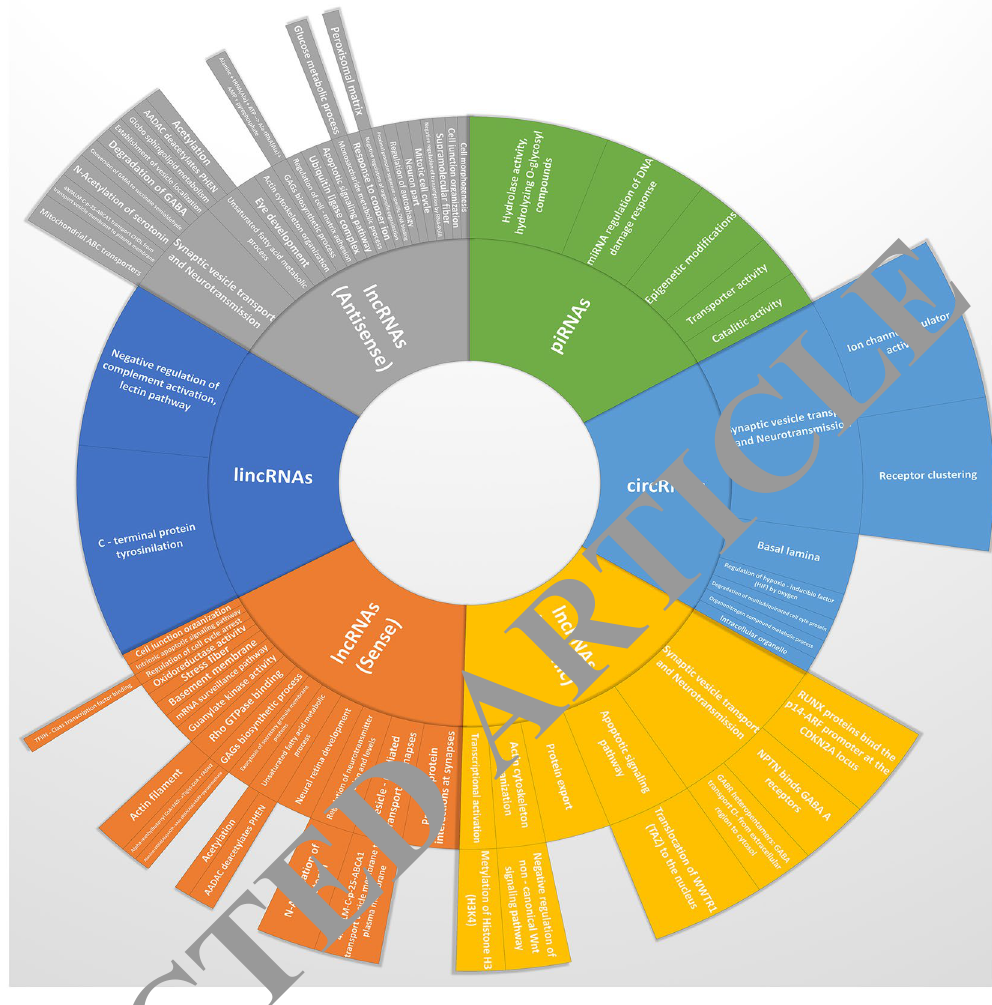
Figure 5. Sunburst chart of most altered ncRNAs. This type of visualization shows hierarchy through a series of rings, that are sliced for each category node. Each ring corresponds to a GO level in the hierarchy, with the central circle representing the root node made of analyzed ncRNA categories, and the hierarchy moving outwards from it. The angle of each slice is either divided equally under its parent node or made proportional to the percentage of most altered ncRNAs involved in each GO categories. Different colors highlight hierarchal groupings, while font dimension is proportional to up–regulated pathway and sub–pathways (bigger font) and down–regulated ones (smaller